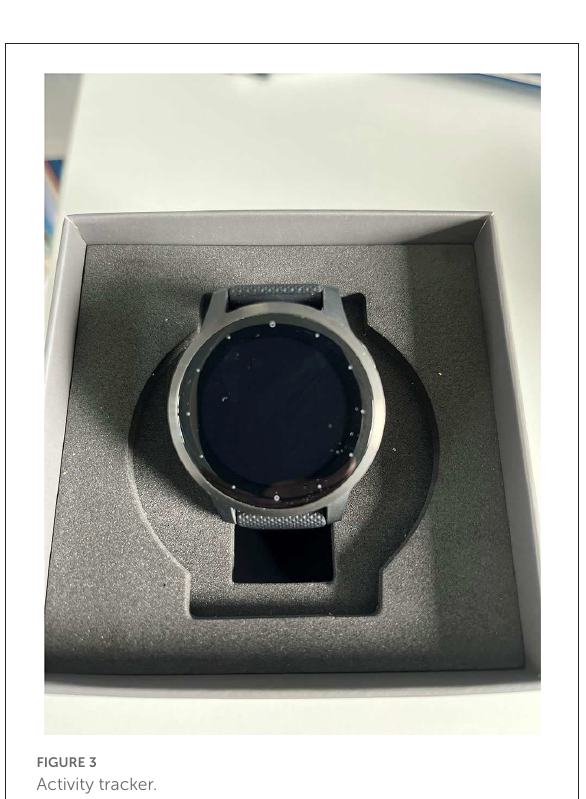
FIGURE3 Activity